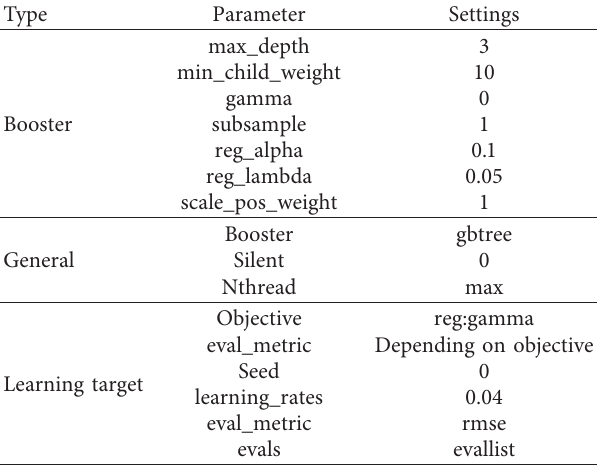
Figure 7: reg_alpha and reg_lambda up-direction and down-direction parameter adjustment results. Table 2: Parameter settings of XGBoost-I